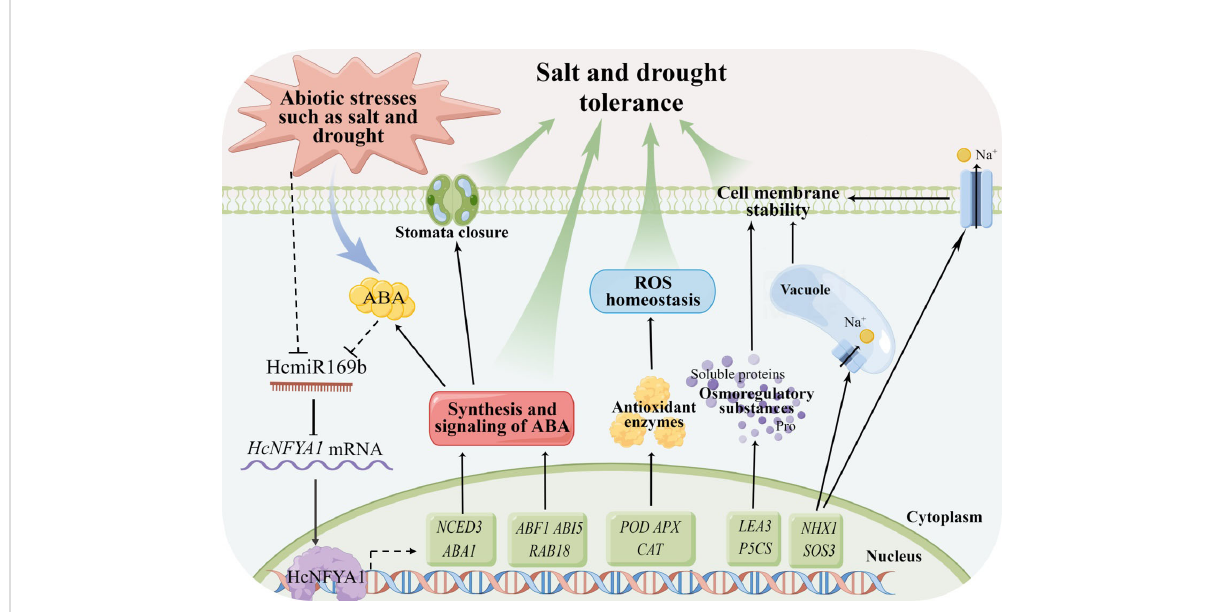
FIGURE 8 Halostachys caspica miR169b/NFYA1 module participates in the regulation network of plant tolerance to salt and drought